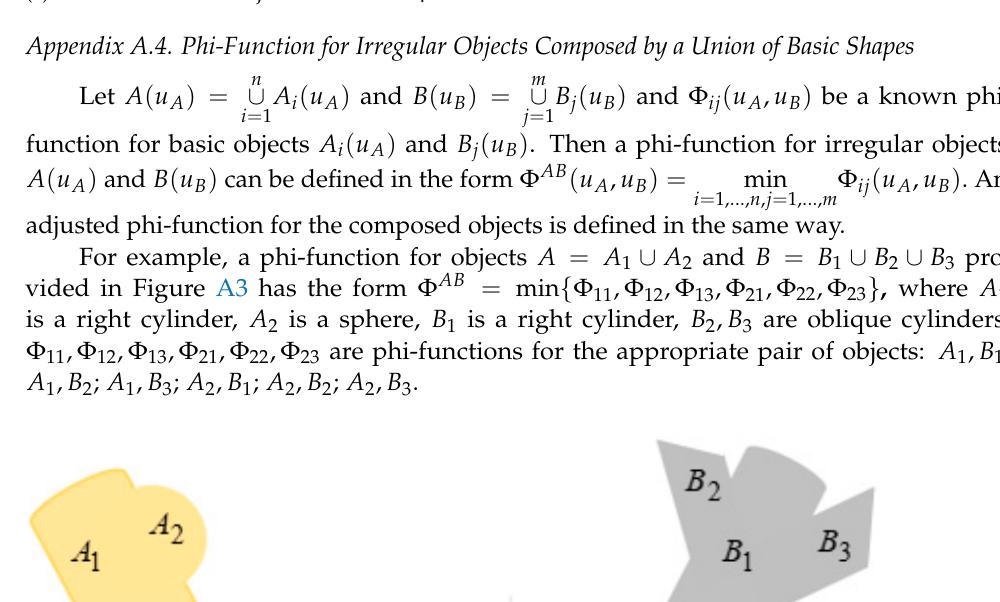
Figure A2. An adjusted phi-function differentiates three cases of mutual arrangements of a pair of objects: ( a ) distance between objects is greater than ρ ; ( b ) distance between objects is equal to ρ ; ( c ) distance between objects is less than ρ .